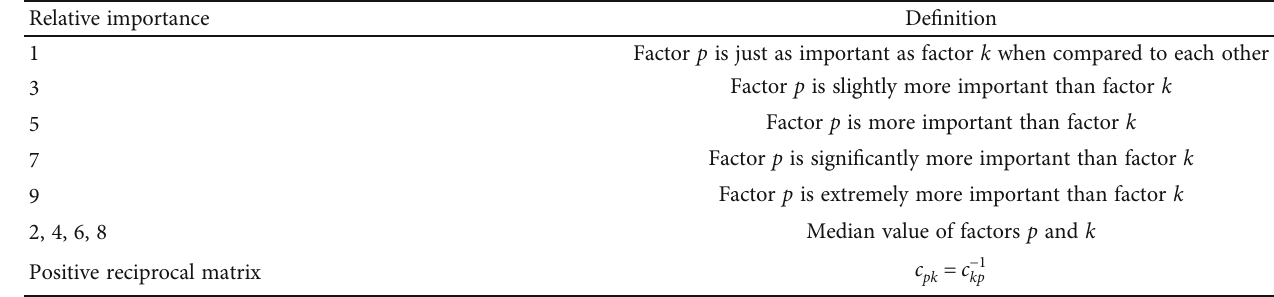
Table 1: Judgement matrix scale.